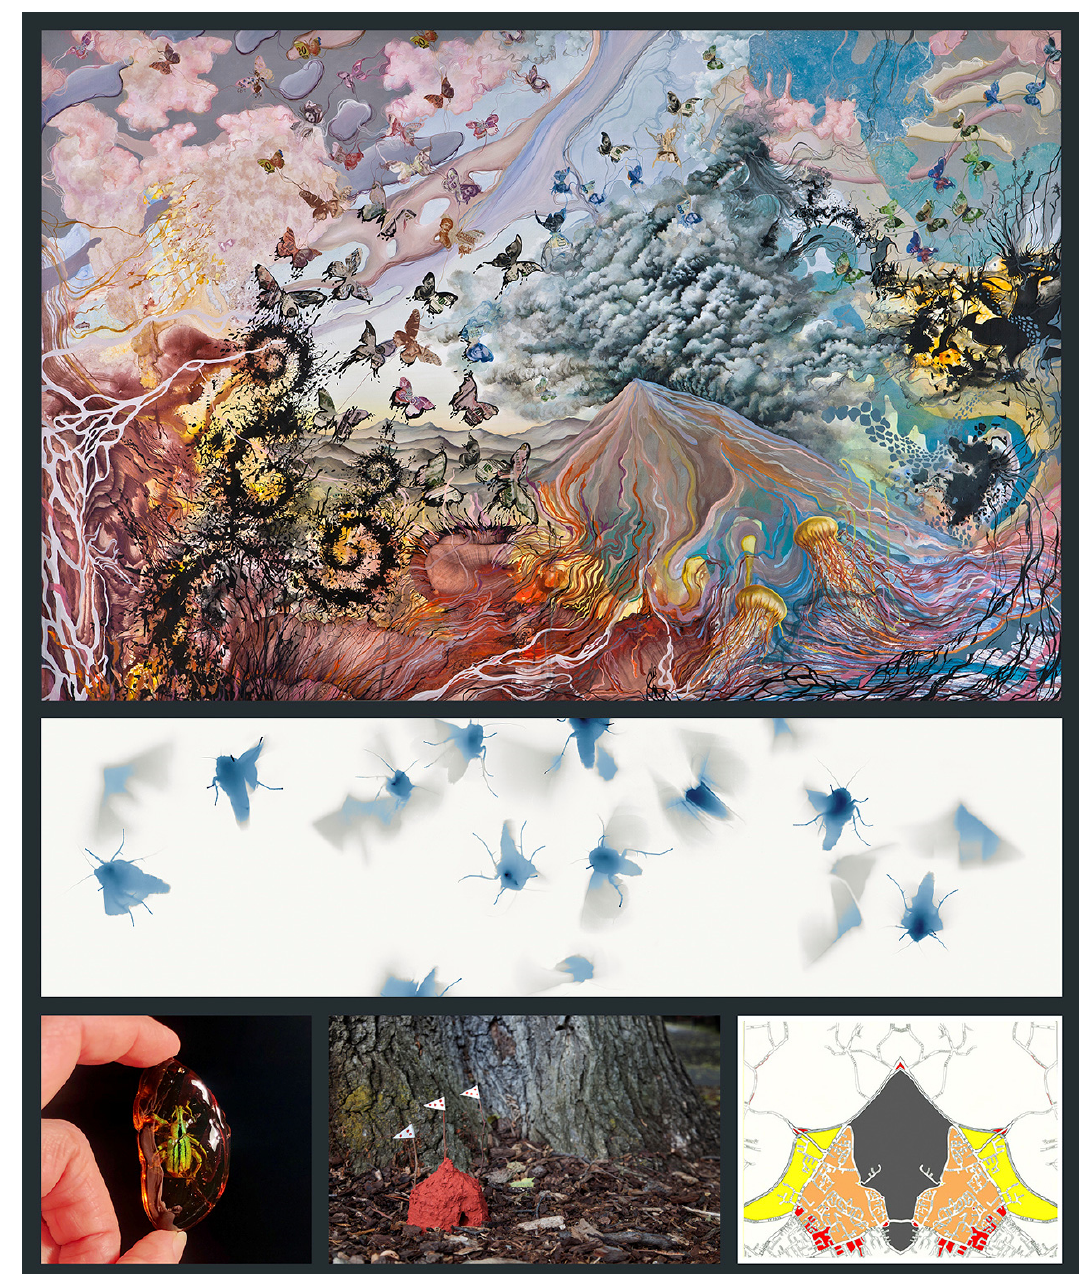
Figure 1. Insect art addressing habitat destruction or climate change. Butterflies in Melt ( top ; acrylic, ink and collage; 2012) are converted into monetized creatures and speak to the effects of economic power and devastation. Erika Harrsch: “I created [ Melt ] after I saw from the plane flying over the north pole all the detached fragments of melting ice.” Moth Liturgy 1 ( middle ; pigment inkjet print from digitally modified scans of gelatin silver film photograms, 2016) is from Harry Nankin’s series featuring live Bogong moths, Agrotis infusa (Boisduval, 1832), from an ecosystem in the Australian Alps “doomed by anthropogenic climate change.” A weevil ( bottom left ; in resin, 2020) from Jenny Kendler’s Amber Archive . Perdita Phillips created Termite Embassy ( bottom center ; papier-m â ch é and cardboard, 2015) in response to the Paris Climate Accords. A butterfly emerges from a modified and mirrored map of Great Hollands, an area that will metamorphose over time “to accommodate our growing population” in Surrey Butterflies ( bottom right ; Angela Thames; 2007–2008). All images are courtesy and copyright of the